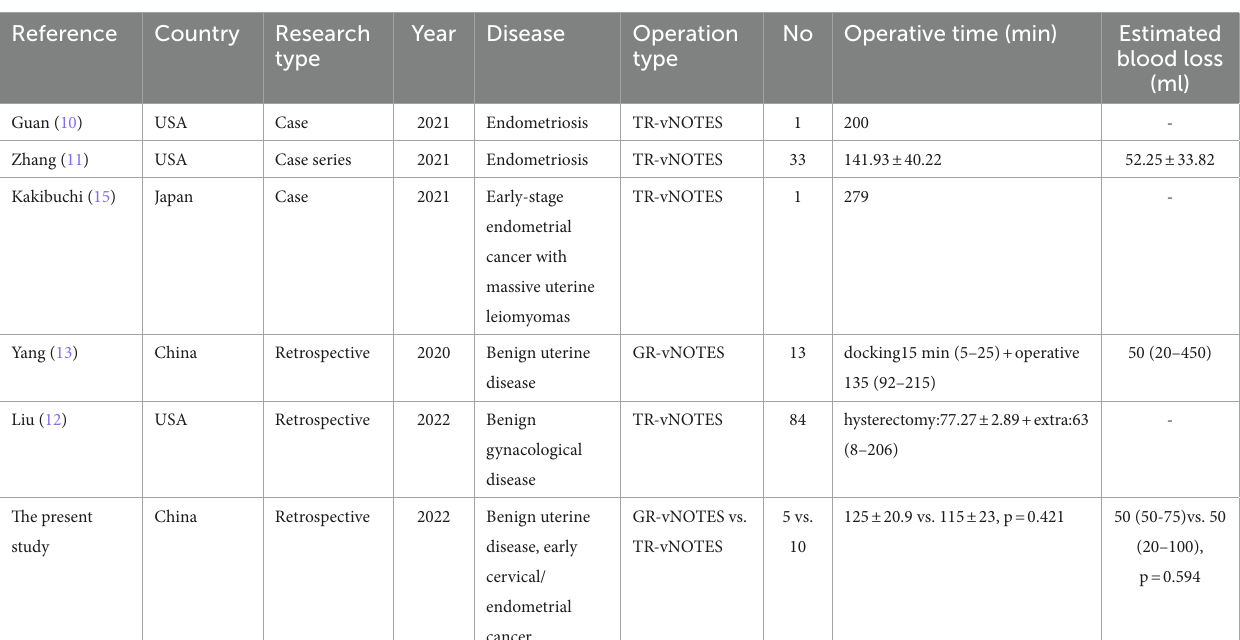
TABLE 2 The literature review about GR-vNOTES or TR-vNOTES in hysterectomy. Reference